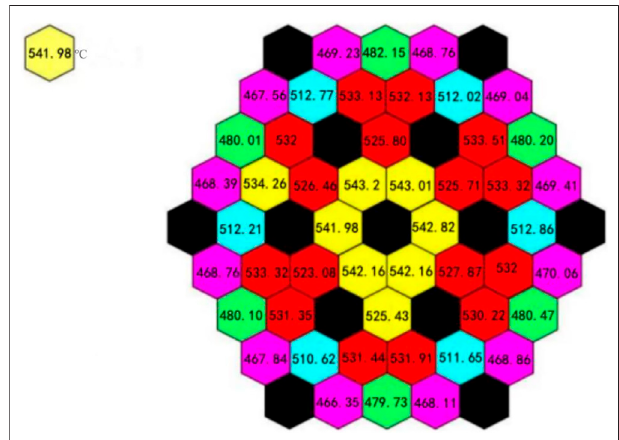
FIGURE 14 | Outlet temperature without zoning.